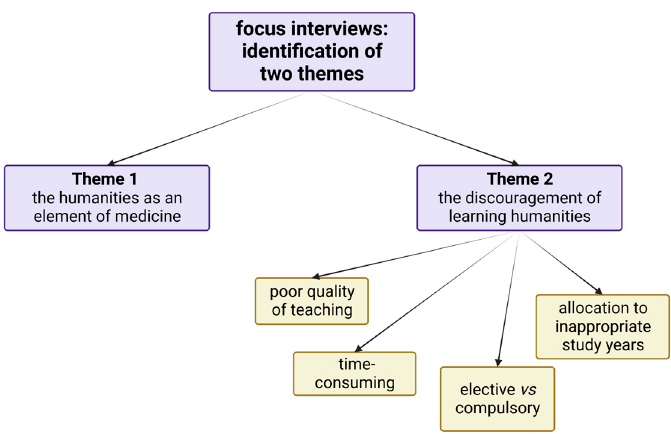
Figure 1. Focus interviews allowed the identification of spontaneous themes and sub-themes. Created with